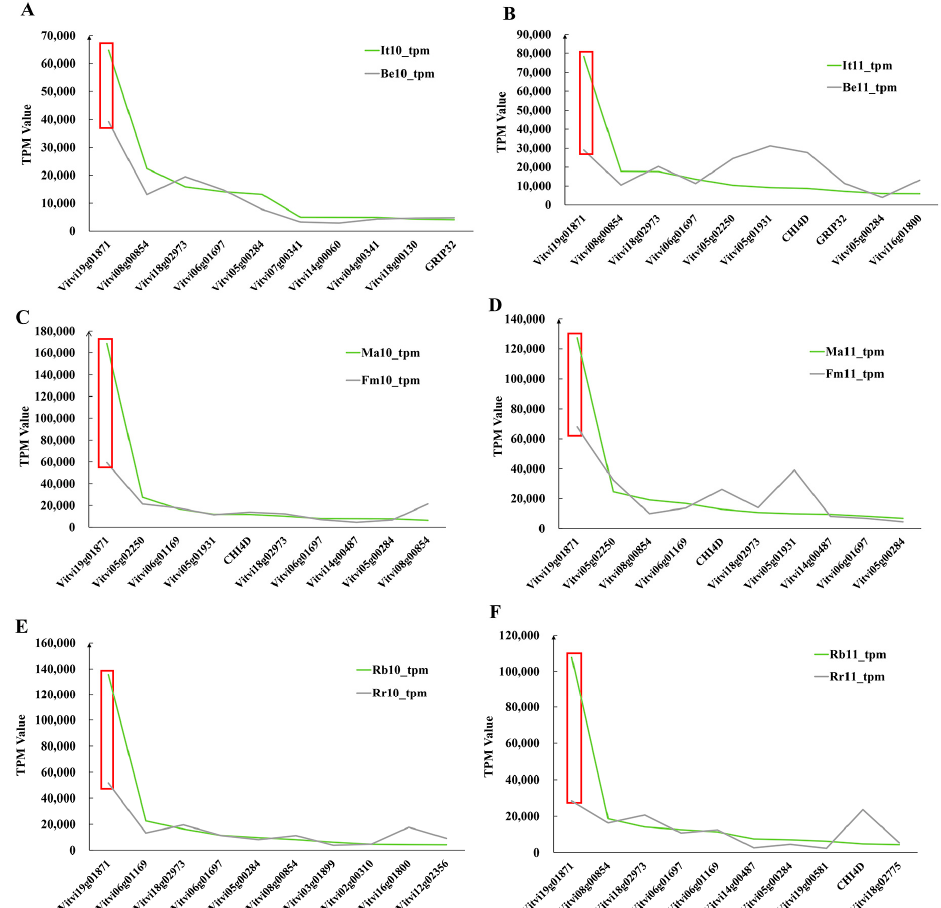
Figure 8. ( A ) ‘Italia’ ‘Benitaka’ TPM value almost top 10 of gene expression 10 wpf; ( B ) ‘Italia’ ‘Benitaka’ TPM value almost top 10 of gene expression 11 wpf; ( C ) ‘Muscat of Alexandria’ ‘Flame Muscat’ TPM value almost top 10 of gene expression 10 wpf; ( D ) ‘Muscat of Alexandria’ ‘Flame Muscat’ TPM value almost top 10 of gene expression 11 wpf; ( E ) ‘Rosario Bianco’ ‘Rosario Rosso’ TPM value almost top 10 of gene expression 10 wpf; ( F ) ‘Rosario Bianco’ ‘Rosario Rosso’ Top TPM value almost top 10 of gene expression 11 wpf. The green line represents the TPM values of white cultivars; the black line represents the TPM values of red and black cultivar.